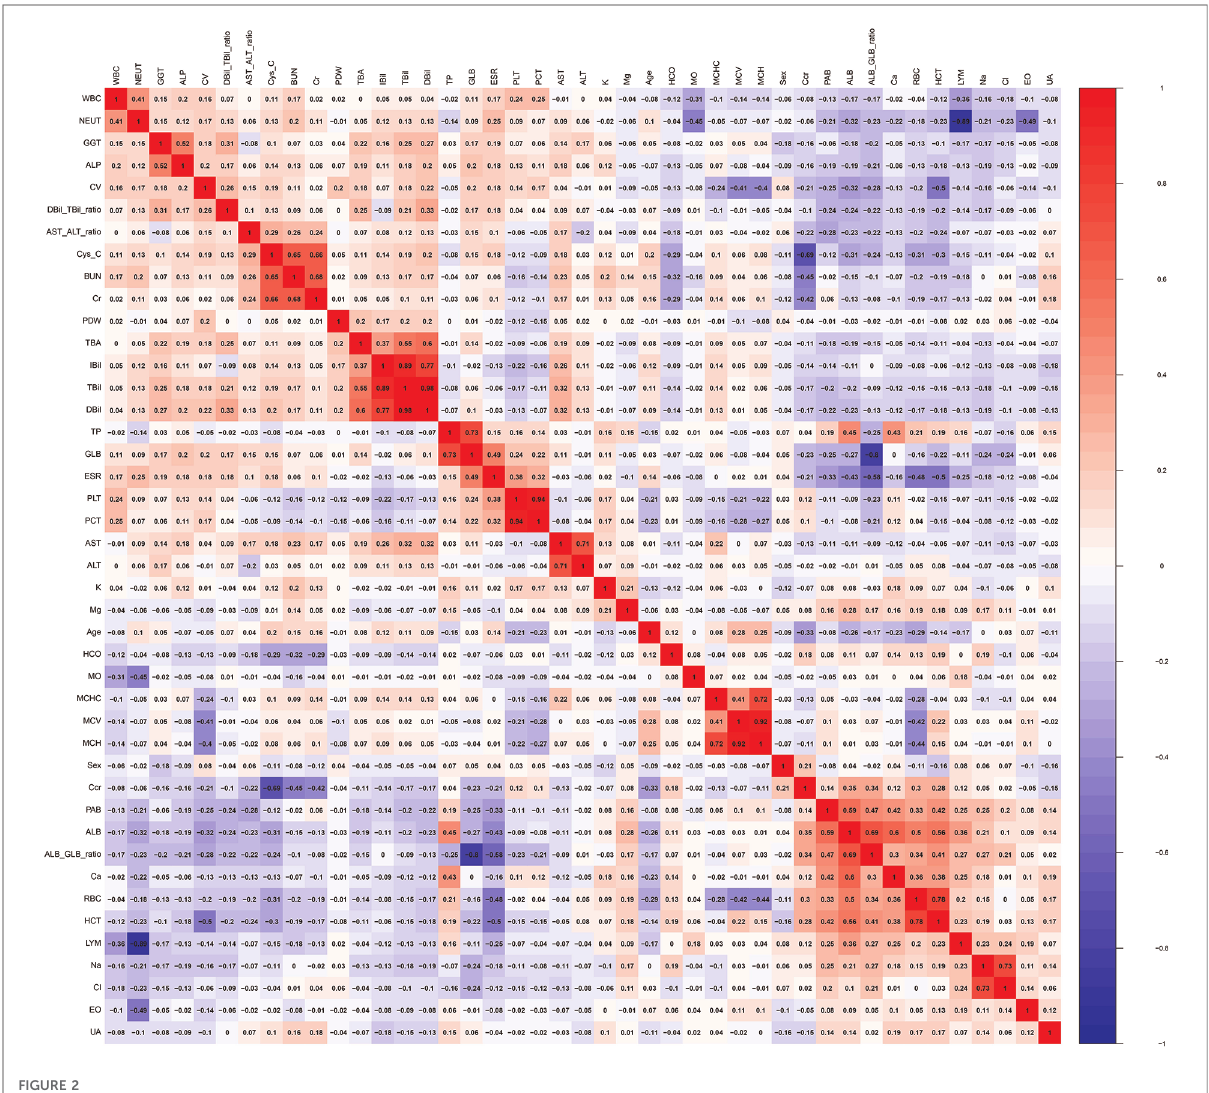
FIGURE 2 Correlation between all